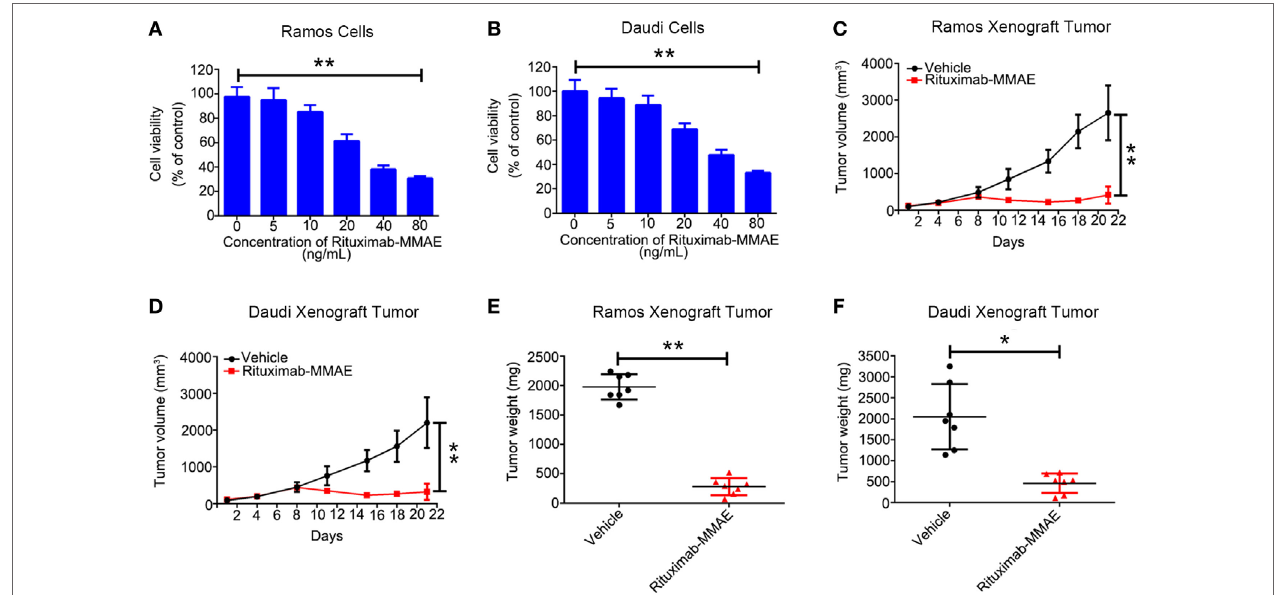
FigUre 1 | Rituximab-monomethyl auristatin E (MMAE) showed a potent antitumor effect in vitro and in vivo . (a,B) MTT assay was used to detect cytotoxicity of Rituximab-MMAE in CD20 positive cells Ramos and Daudi cells. The data were presented as mean ± SD of three independent experiments (Student’s t -test, * P < 0.05 and ** P < 0.01). (c,D) BABL/c nude mice were transplanted subcutaneously with Ramos cells and Daudi cells. Xenograft tumor volume was evaluated every other day by direct caliper measurements. There are seven mice in each group. The data were presented as means ± SD. (e,F) After treatment